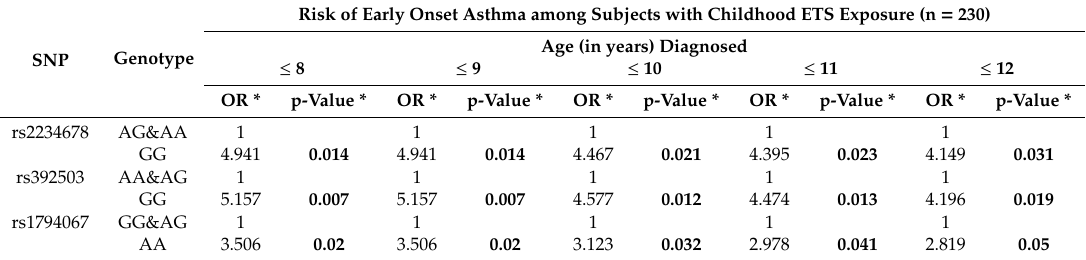
Table A1. SNP genotypic association with early onset asthma using di ff erent cuto ff for age diagnosed.